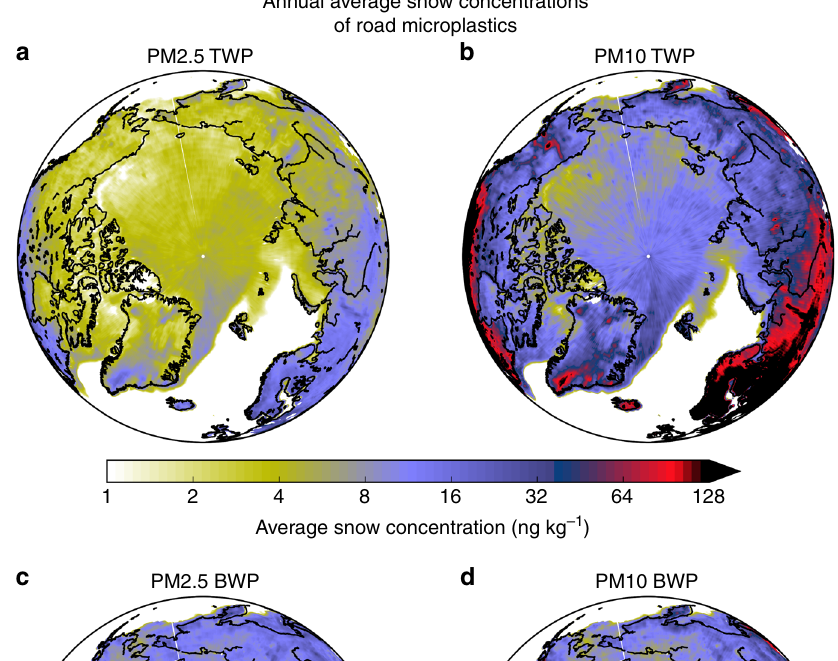
methodological limitations. According to Stylios 64 , a micro fi bre is a fi bre with <1 decitex (dtex) per fi lament, with the most common types being from polyesters and polyamides (1 dtex = 1 mg per 10 m). Since the majority of the fi bres was <25 μ m size, these number concentrations can be converted to mass concentrations